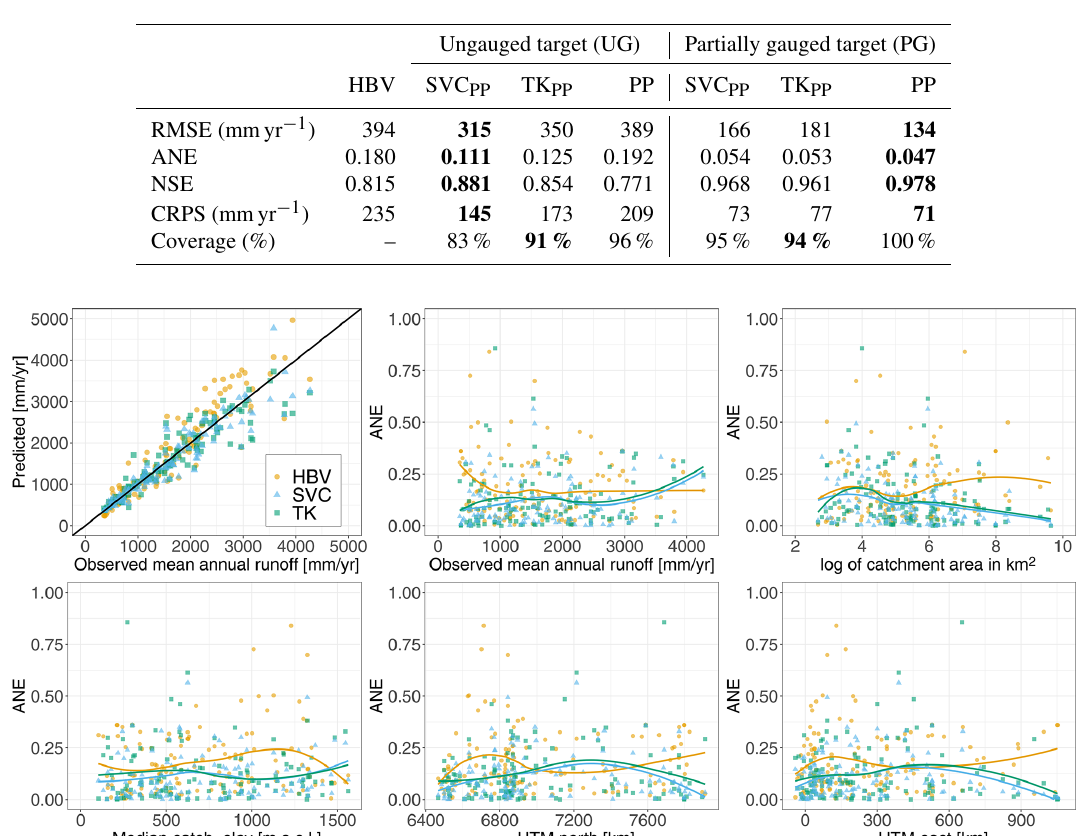
Figure 8. Predictive performance of the methods (HBV, SVC PP , and TK PP ) for predictions in ungauged catchments (UG) performed by cross-validation. The first plot shows the fit between the predictions and the observations for the methods. The remaining plots show the ANE for each of the 127 cross-validation catchments plotted against selected catchment attributes; i.e., the observed runoff, catchment area, median catchment elevation, UTM33 north, and UTM33 east. The fitted curves are regression splines (made by geom_smooth() in R